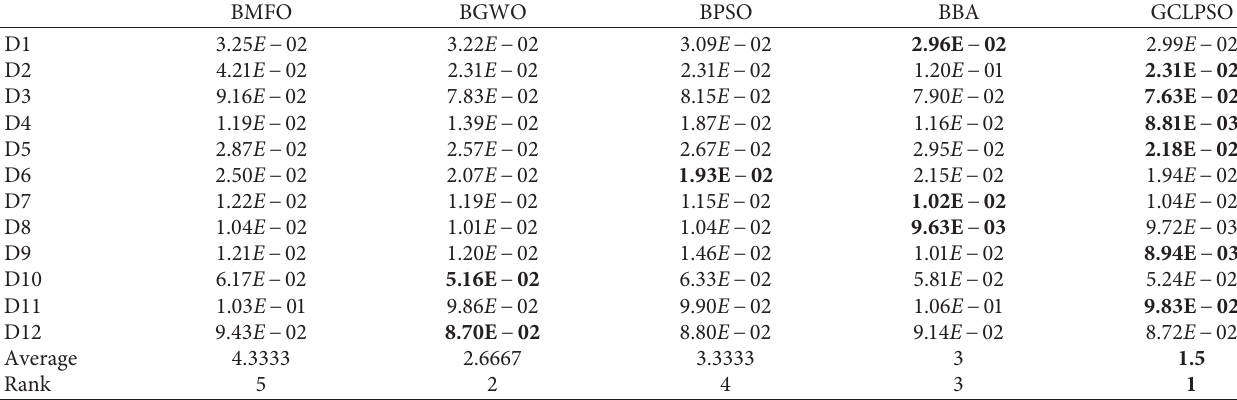
Table 7: Average fitness value of the GCLPSO and other feature selection algorithms on the dataset.